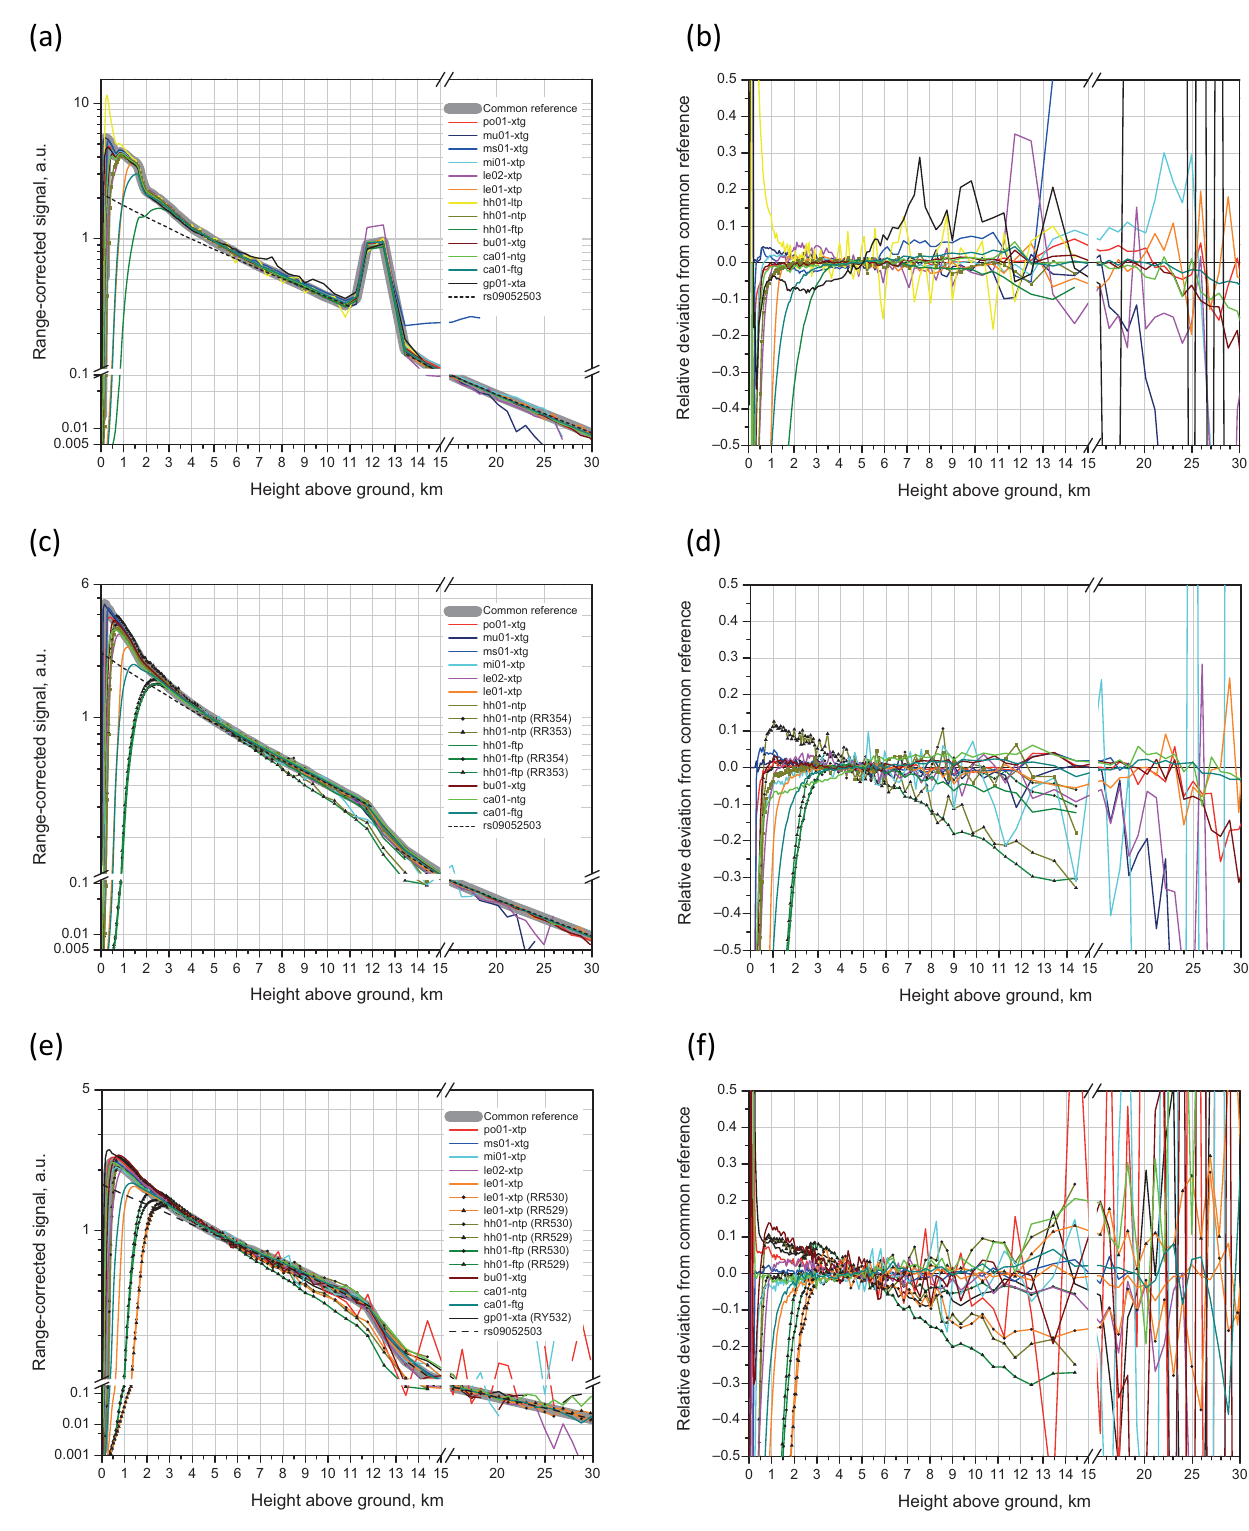
Figure 3. Comparison of range-corrected signals at (a) 355nm, (c) 387nm, and (e) 607nm and their deviations from the common reference (b, d, f) . The measurement was performed during EARLI09 on 25 May 2009,